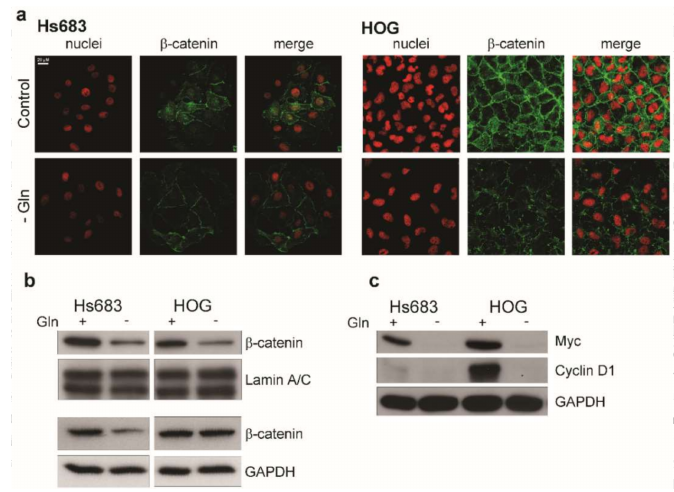
Figure 5. Gln starvation inhibits the Wnt/ β -catenin pathway. ( a – c ) Hs683 and HOG cells incubated in the presence (Control, +) or in the absence (- Gln, − ) of Gln for 19 h. ( a ) Immunofluorescence of β -catenin. Single confocal sections of representative fields. Red, nuclei, Propidium iodide; Green, β -catenin. Bar = 20 µ m ( b ) Western blot of β -catenin in nuclear (above) or in cytosolic (below) extracts of Hs683 and HOG cells. Lamin A/C or GAPDH were used for loading control. ( c ) Western blot of Myc and cyclin D1. GAPDH was used for loading control. Representative experiments are shown.